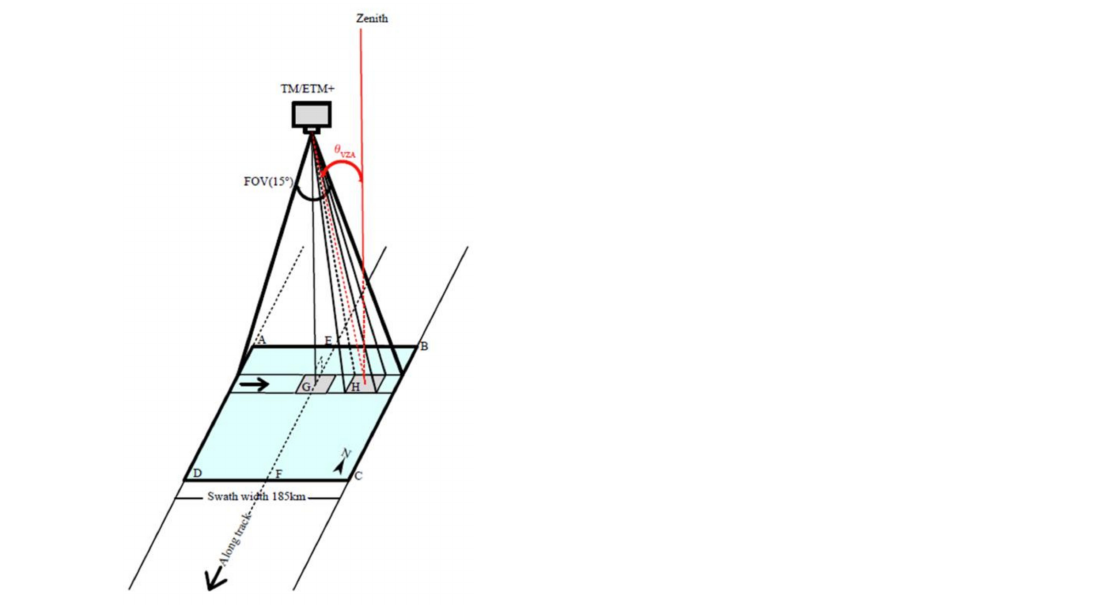
Figure 6. Schematic diagram of calculation method for the VZA of an image pixel. ABCD represents a scene, EF is the nadir view line, G is the projection pixel of the sensor on the ground, and E is the midpoint of AB on the upper boundary of the swath. The field of view (FOV) of TM/ETM+ is 15 ◦ . The angle between the two red lines in the figure is θ VZA , corresponding to the VZA of arbitrary pixel H of the TM/ETM+